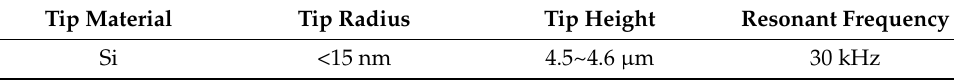
Figure 3. The prototype CR-AFM system used in experiments. Table 1. Property parameters of the probe.